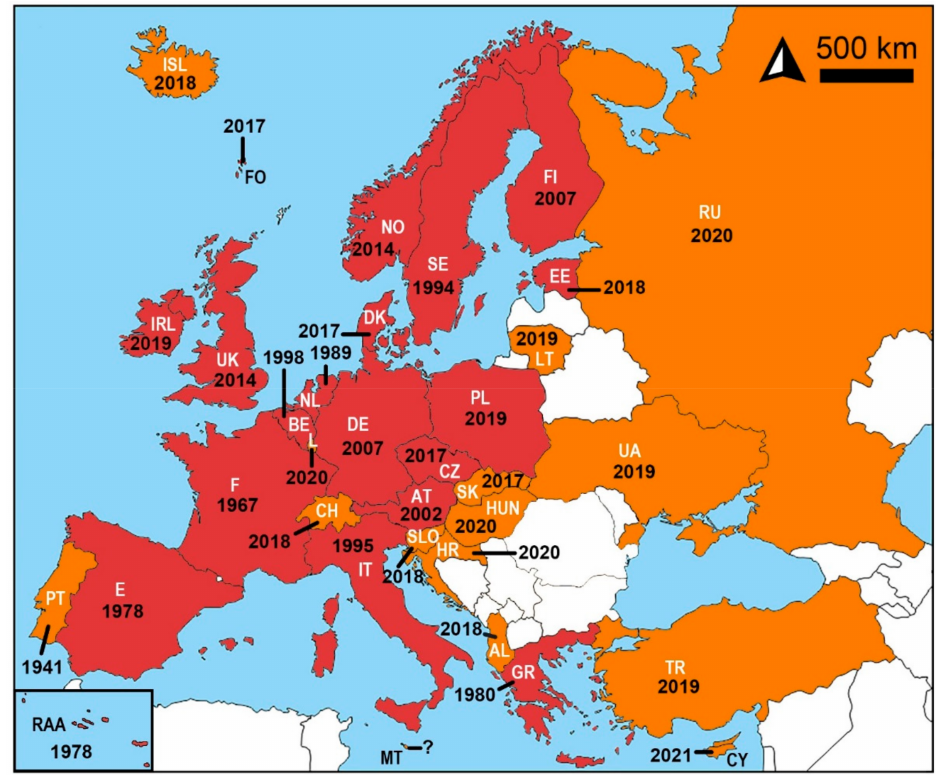
Figure 2. The distribution of Ctenolepisma longicaudatum in Europe; red: confirmed records; and orange: unverified records. The distribution data from white countries are not available/were not found among the sources. Table 2. The reported occurrence of Ctenolepisma longicaudatum in Czechia in 2017–2021.